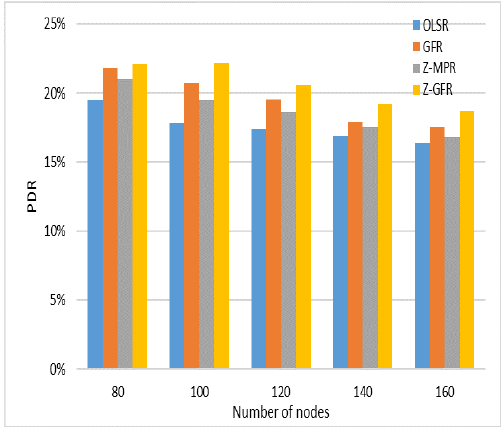
Figure 19. pdr of the udp sockets.